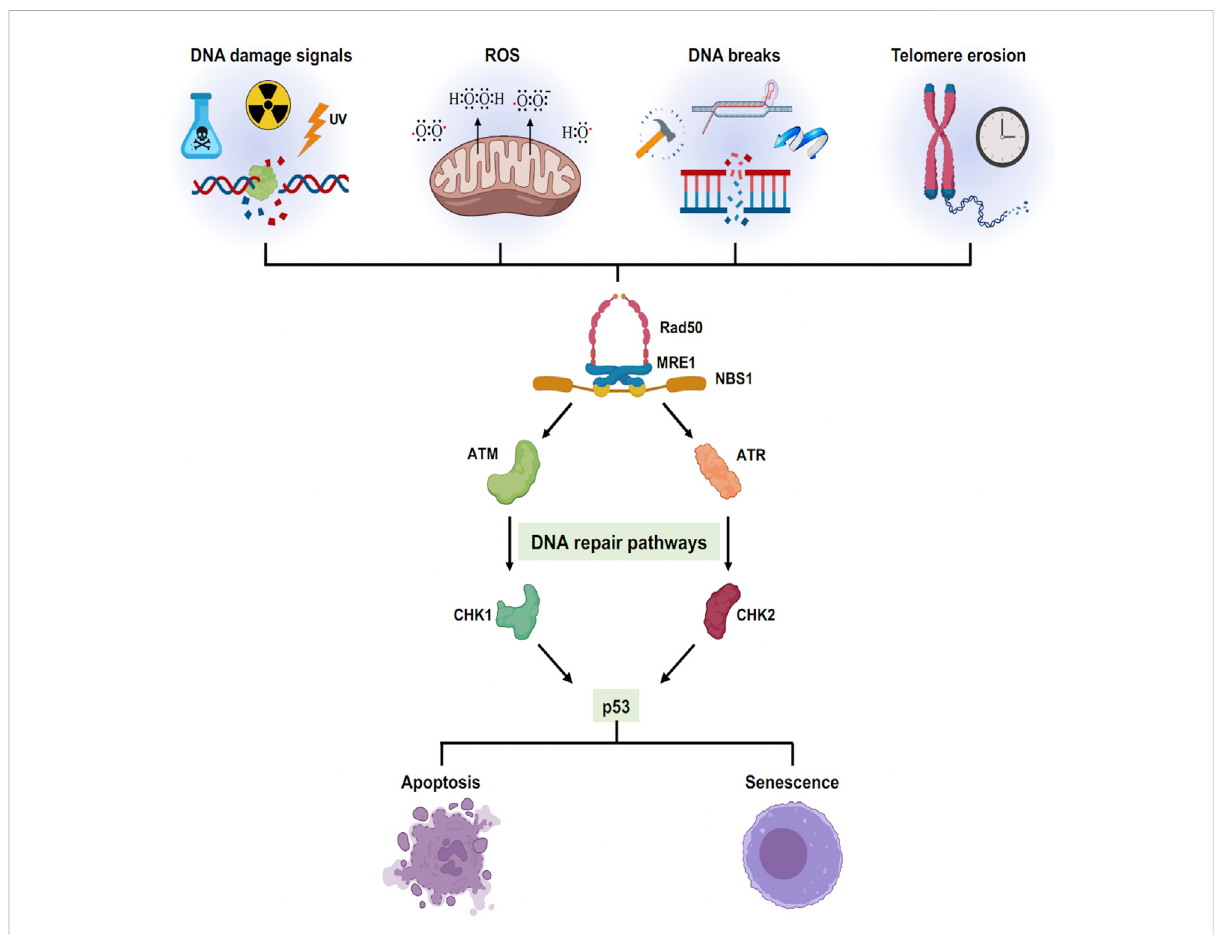
FIGURE 3 Cellular senescence triggered by different stress signals: Different exogenous and endogenous events trigger a stress response pathway. The stress elicits a DNA damage responsive pathway via ATM/ATR converging onto p53 which decides the cellular fate either to cell death or cell growth